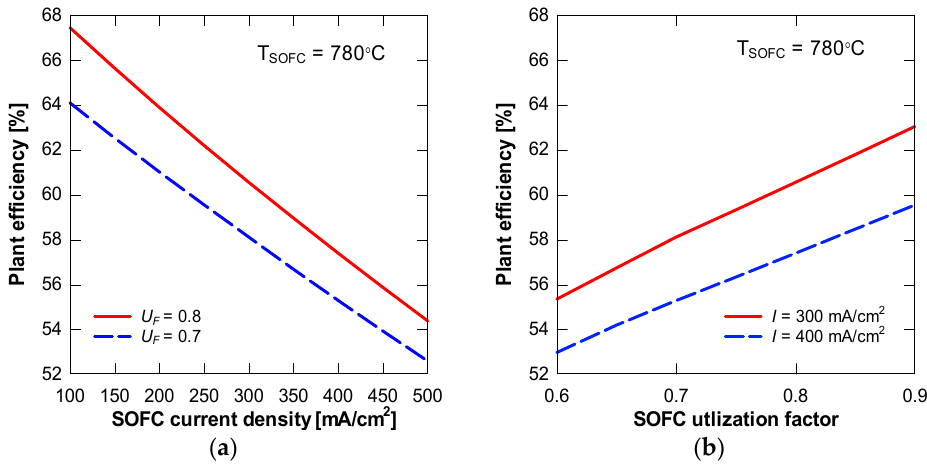
Figure 10. Effect of SOFC ( a ) current density and ( b ) utilization factor on plant efficiency of repowering with SOFC.